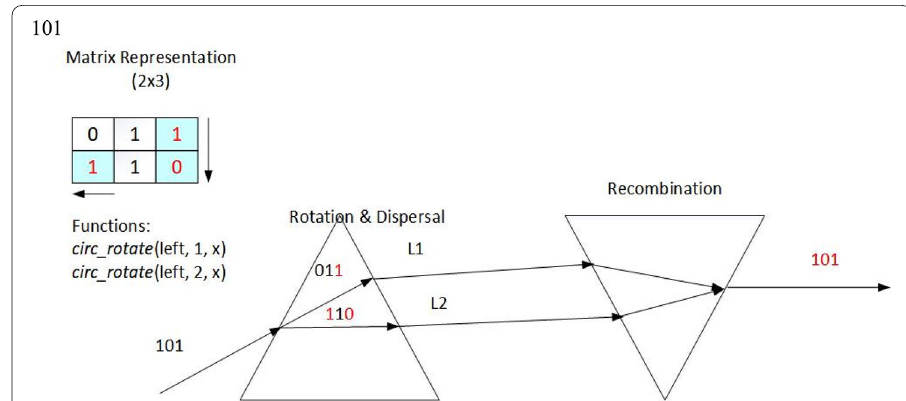
Fig. 5 Passing the classical bit string 101 through the bit prism